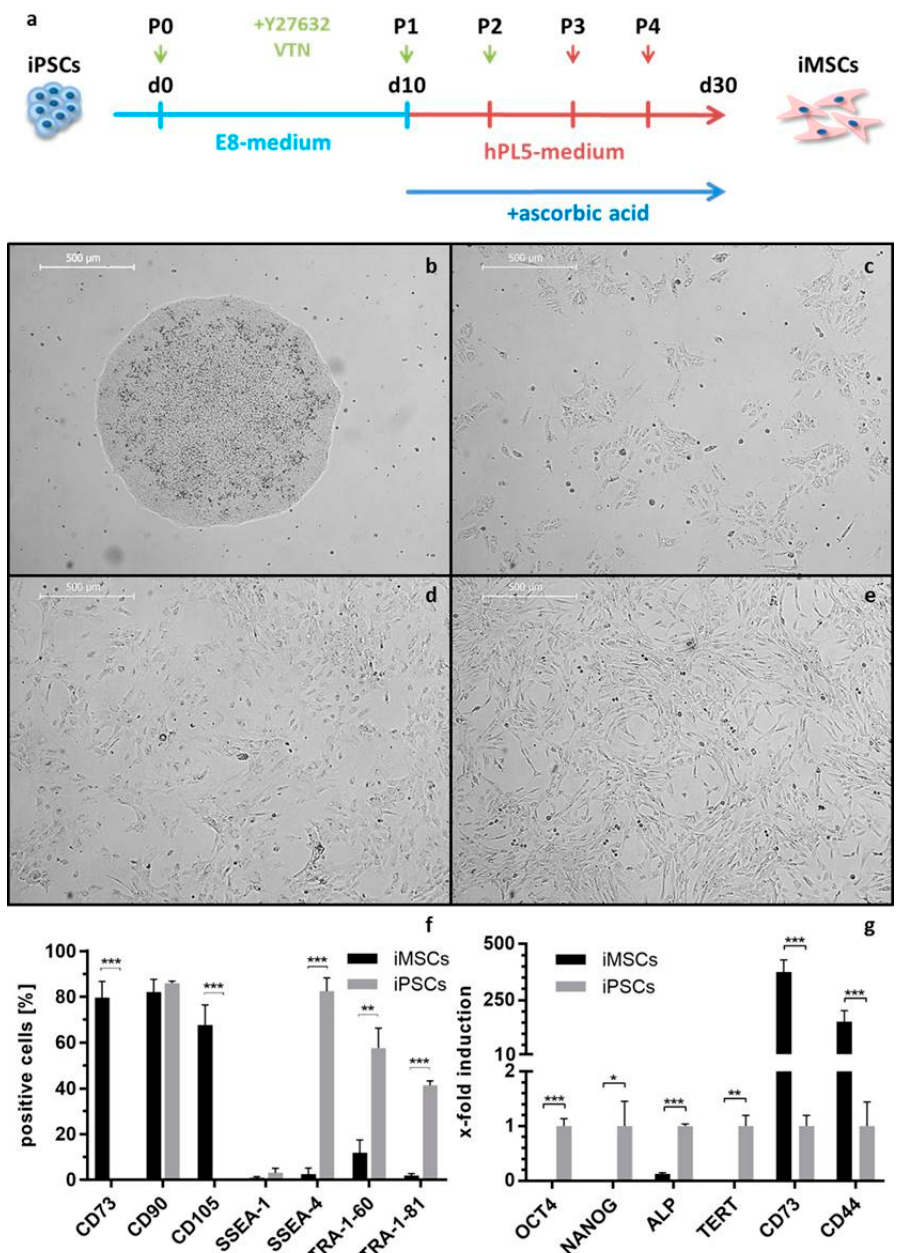
Figure 6. Differentiation of iPSCs into iPSC-derived mesenchymal stem/stromal like cells (iMSCs). ( a ) Timeline: iPSCs were seeded onto vitronectin coated plates in the presence of the ROCK inhibitor Y27632 and cultivated for 10 days in E8 medium (light blue line). Thereafter, human platelet lysate hPL5 medium containing 150 µM ascorbic acid was added to the cells (red line). Cells were passaged 3–5 times until they showed homogeneous MSC-like morphology after approximately 30 days. ( b – e ) Change of morphology during the differentiation of iPSCs into iMSCs. ( b ) iPSC colony before differentiation. ( c ) Cells after single cell plating in passage 0. ( d ) Differentiating iMSCs in passage two and ( e ) iMSCs in passage four (scale bars represent 500 µm). ( f ) Surface marker expression of iMSCs compared to iPSCs detected by flow cytometry. ( g ) Gene expression levels of iMSCs were normalized to levels of the housekeeping gene glyceraldehyde 3-phosphate dehydrogenase (GAPDH) and presented as x-fold induction relative to iPSCs (set to 1). Differences in surface marker, and gene expression were compared using Student’s t -test. ( n = 3, * p < 0.05, ** p < 0.01, *** p < 0.001).